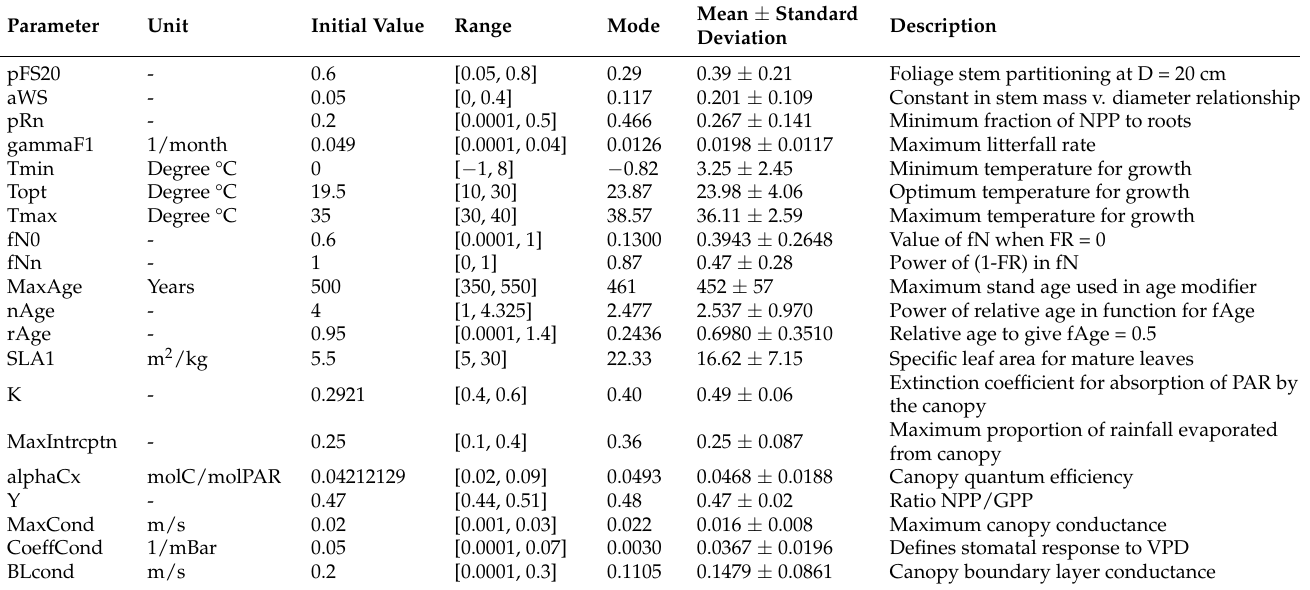
Table 7. Initial values, ranges, and posterior distributions of the 20 optimized 3-PG model parameters.